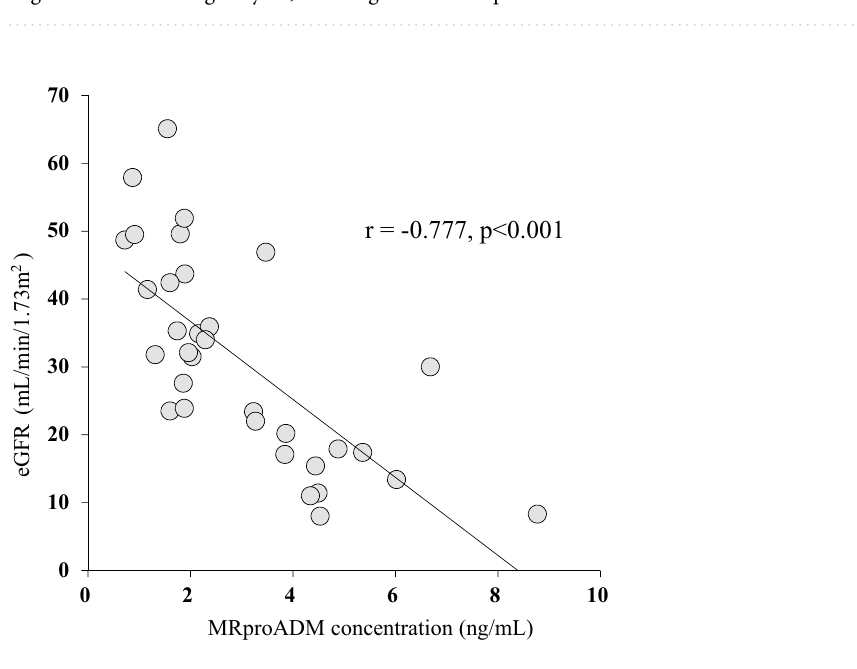
Figure 1. Correlation between mid-regional pro-adrenomedullin (MR-proADM) and estimated glomerular filtration rate (eGFR) in chronic kidney disease patients with poor blood pressure